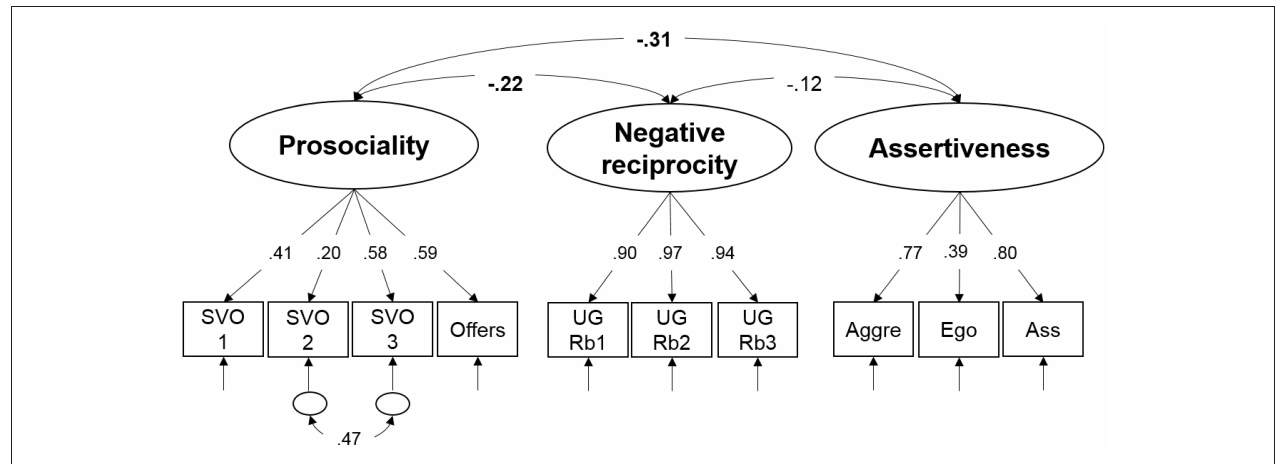
FIGURE 3 | Schematic representation of the measurement model of prosociality, negative reciprocity and assertiveness. See the caption of Figure 2 explaining the general conventions of the graphical language visualizing latent variable models. SVO, Social value orientation; UG, Ultimatum Game; Rb1, Rejection of unfair offers in bloc 1; Rb2, Rejection of unfair offers in bloc 2; Rb3, Rejection of unfair offers in bloc 3; Aggre, Aggressive; Ego, Egoistic; Ass, Assertive. Significant relationships between latent factors at p < 0.05 are depicted in bold.